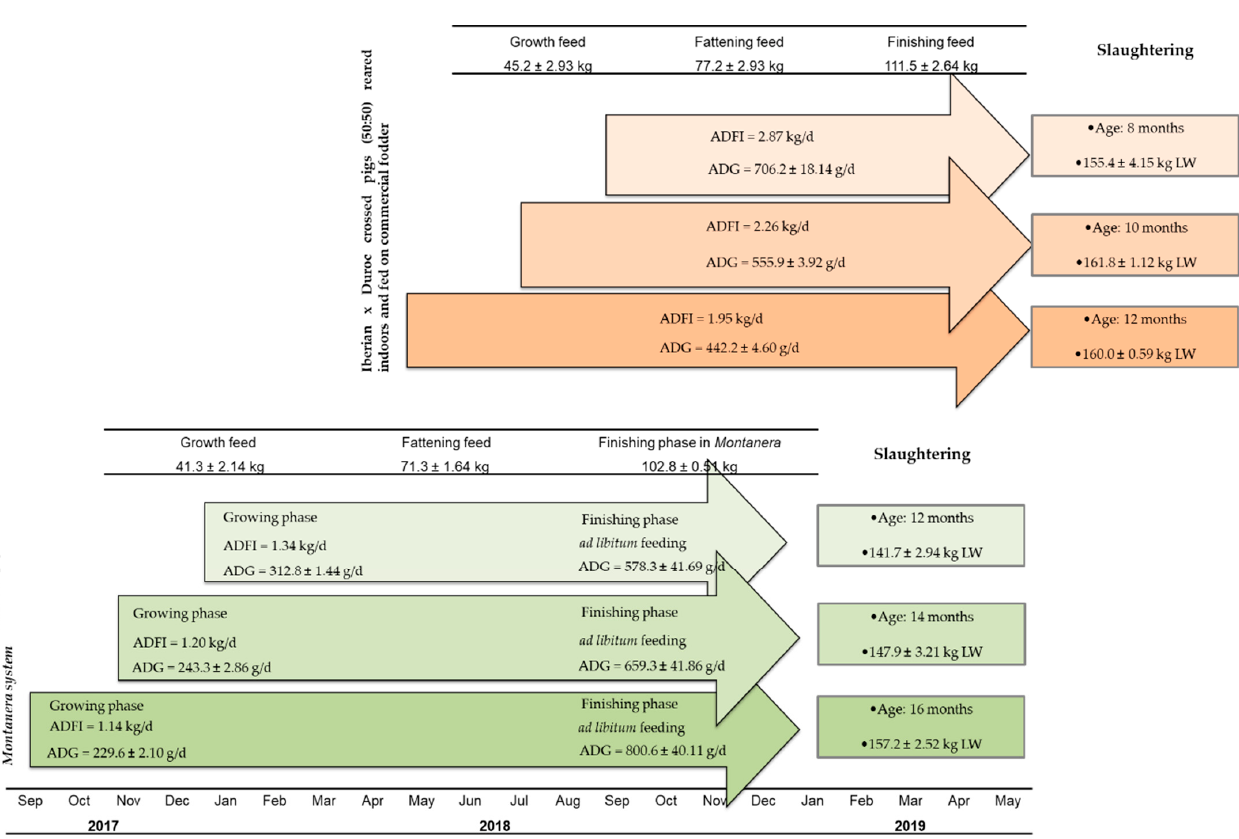
Figure 1. Experimental design of the animal production systems and batches according to slaughter age. Data expressed as arithmetic mean ± standard error. Animal average birth date: 2 September 2018, 4 July 2018 and 5 May 2018 for animals under an intensive production system and slaughtered at 8, 10 and 12 months, respectively, and 7 January 2018, 6 November 2017 and 4 September 2017 for animals under the Montanera production system and slaughtered at 12, 14 and 16 months, respectively. ADFI, average daily feed intake; ADG, average daily gain; LW, live weight.